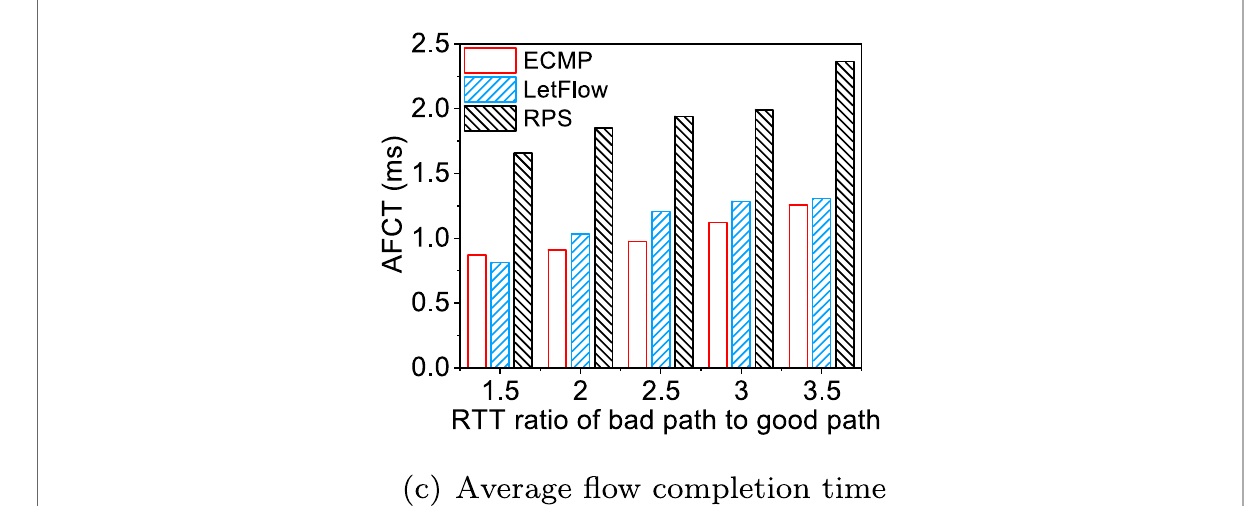
Fig. 2 The performances of short flows